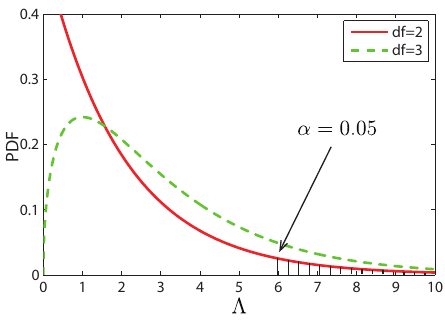
Figure 7. Chi-Squared